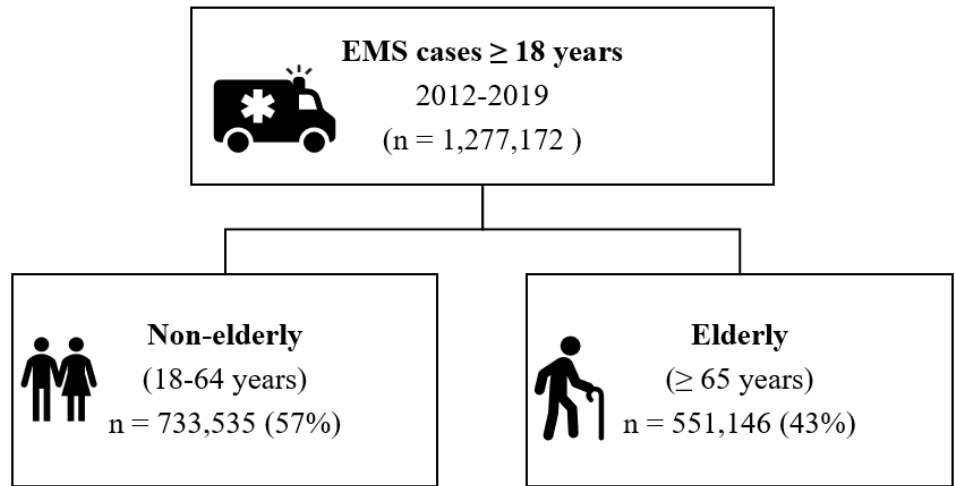
Figure 1. Study flow chart. EMS = Emergency medical system.